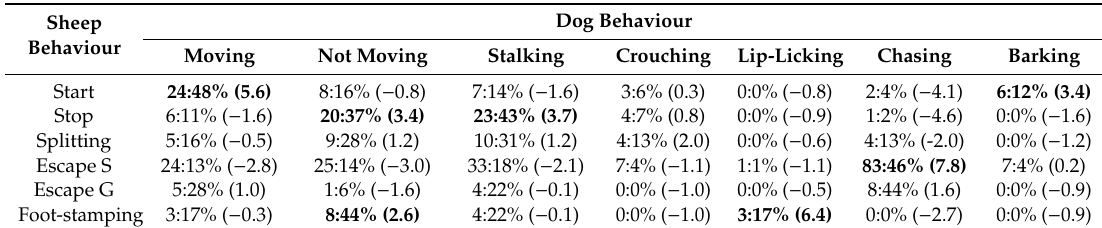
Each paired interaction details three results—Observed frequency: Conditional probability in percentage and adjusted residual in parentheses. Significant positive linkage between behaviours are highlighted in bold. Escape S: Escape single; Escape G: escape